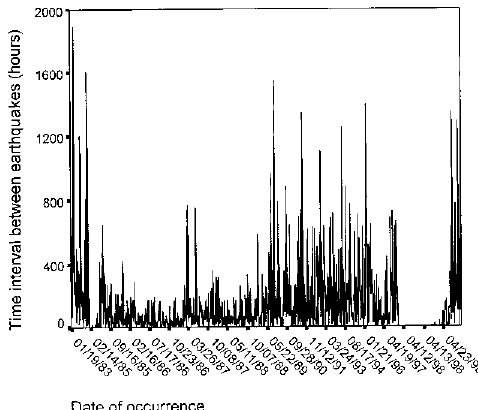
Fig. 4. Sequence of time intervals between conse- cutive earthquakes { (cid:54) t